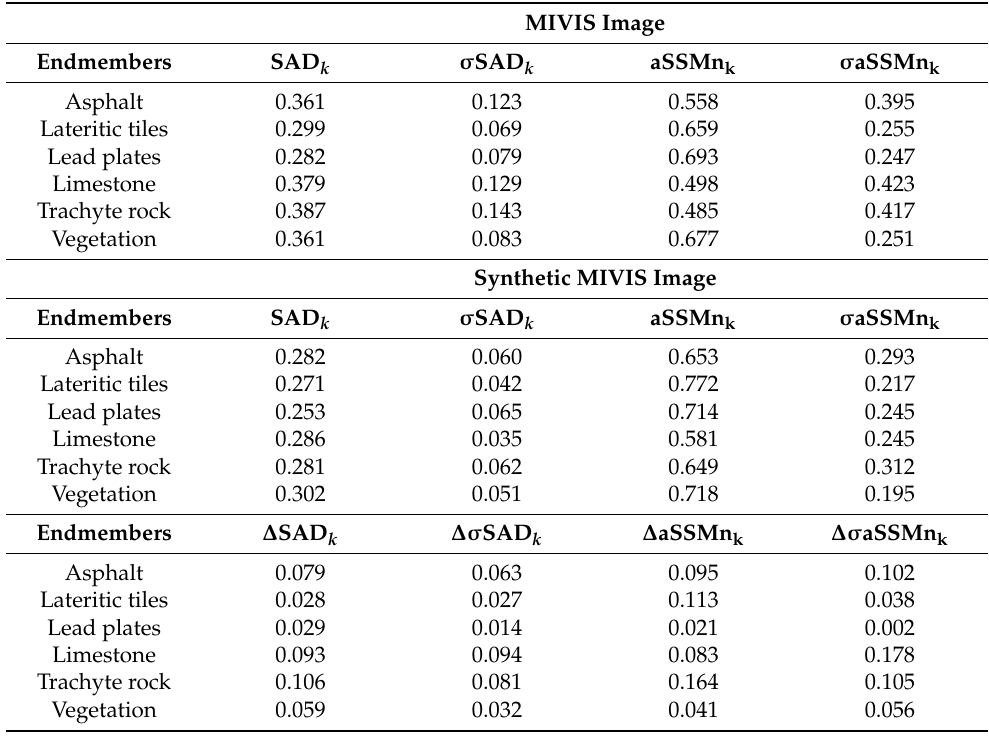
Table 5. In the second method, spectral accuracy estimated with SAD k , σ SAD k , aSSMn k , and σ aSSMn k values that were retrieved from true and synthetic images and the absolute differences between SAD k , σ SAD k , aSSMn k , and σ aSSMn k values obtained from true and synthetic